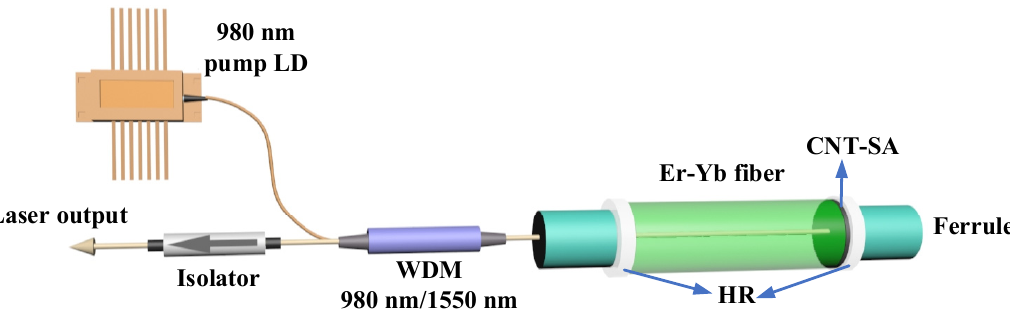
Figure 4: FFPL mode-locked by CNT SAs. WDM, wavelength division multiplexing; HR, high reflector; CNT SA, carbon nanotube saturable absorber. Martinez et al. [191]. © Optical Society of America